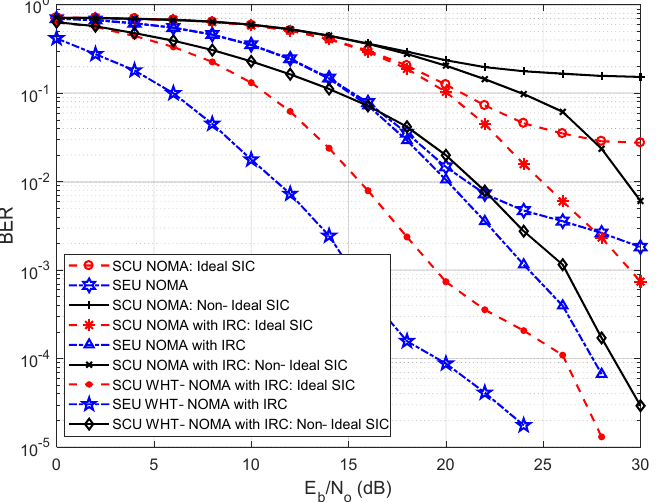
Figure 15. BER performance with IRC using QPSK modulation; NOMA vs. WHT–NOMA, power allocation: SCU = 0.2 and SEU = 0.8.